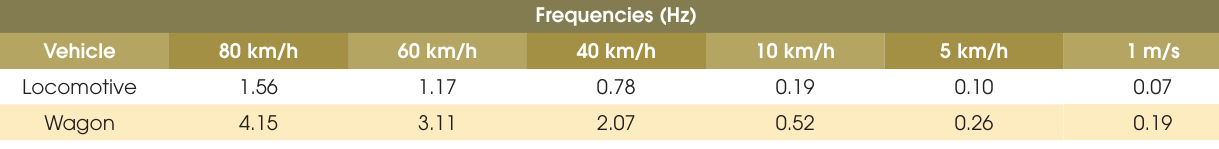
Table 2 – Frequencies related to the distance between axles for varying traffic